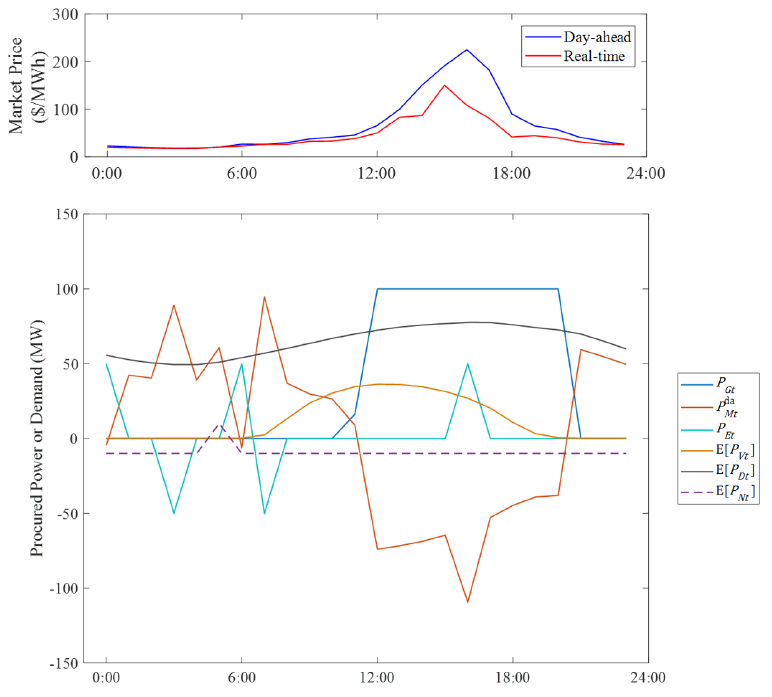
Figure 7. Procurement on 25 September